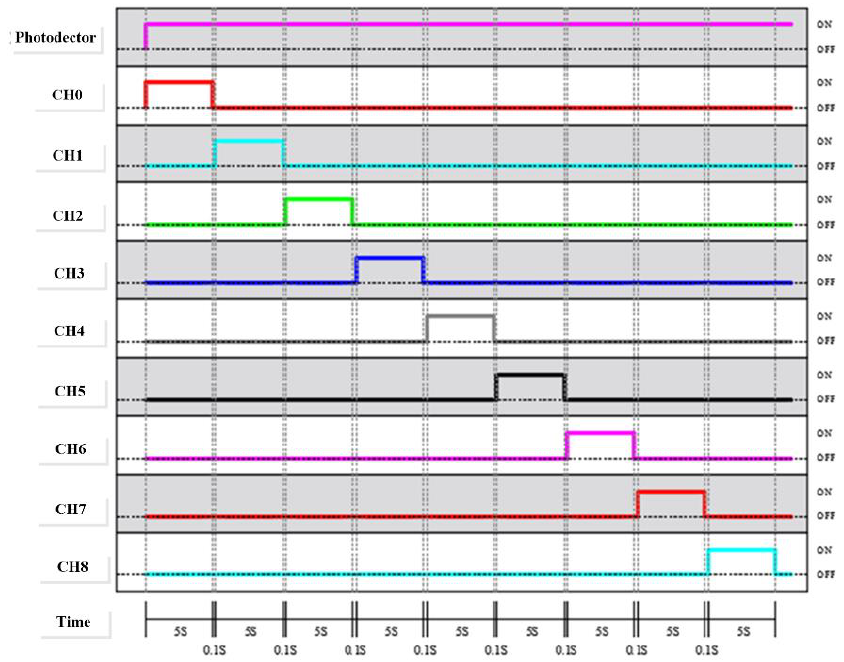
Figure 9. Time table of the photo detector and sensing element actuation. Table 3. Datasheet of the Arduino Micro Development Board.